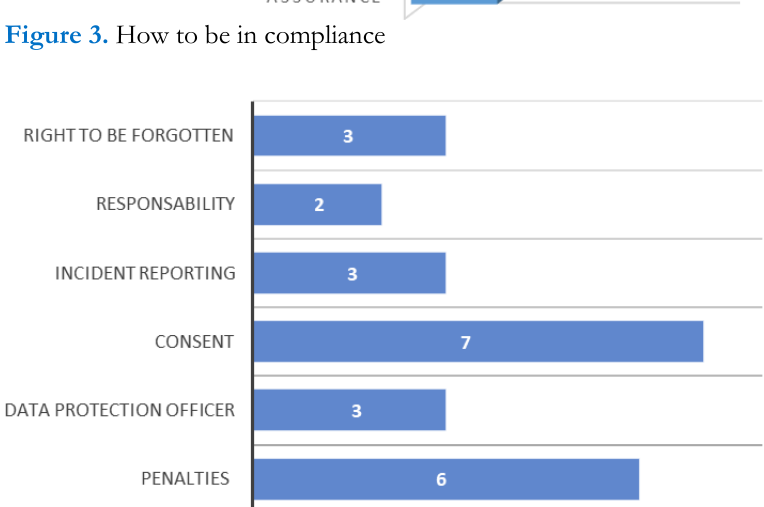
Figure 4. Aspects highly focused in the